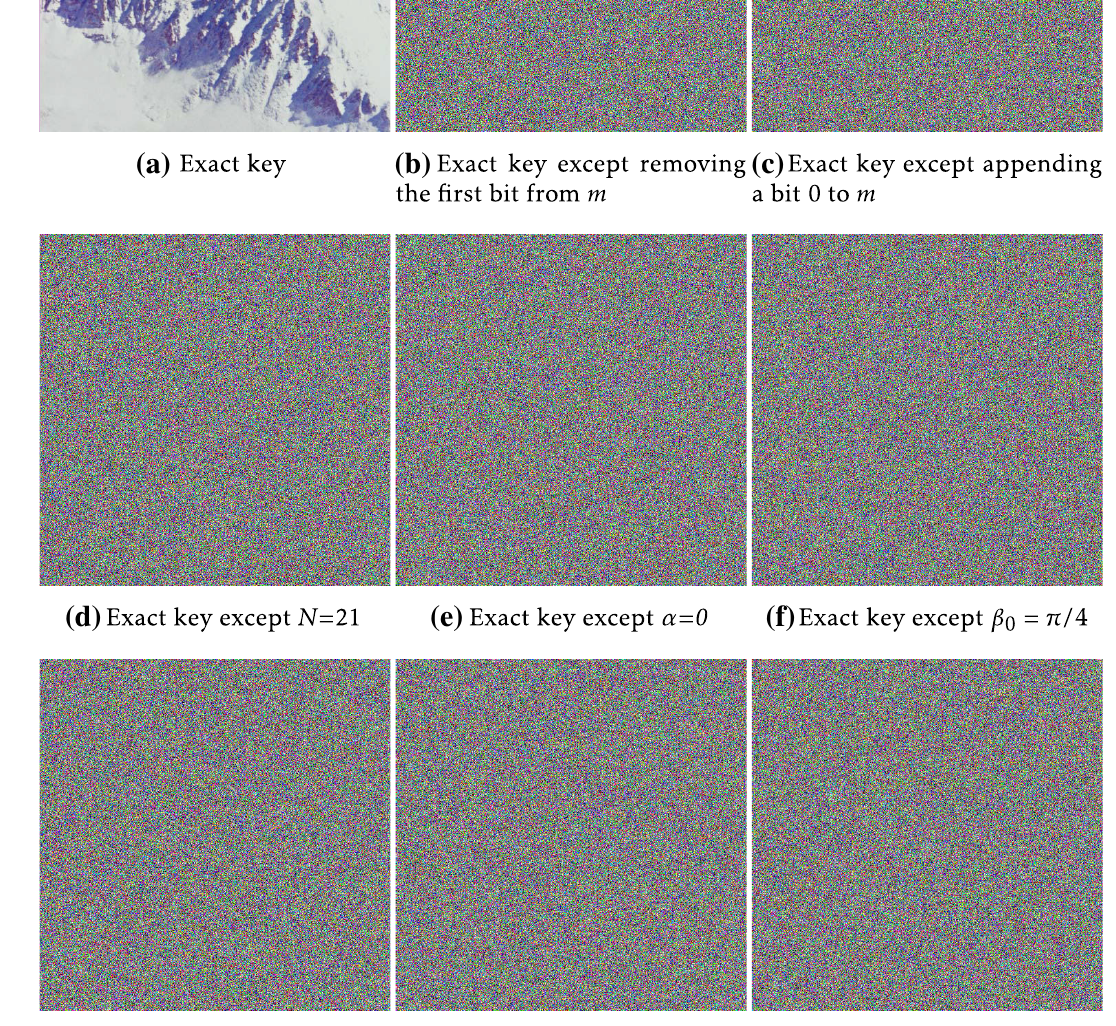
Fig. 8 Key sensitivity results for the proposed approach